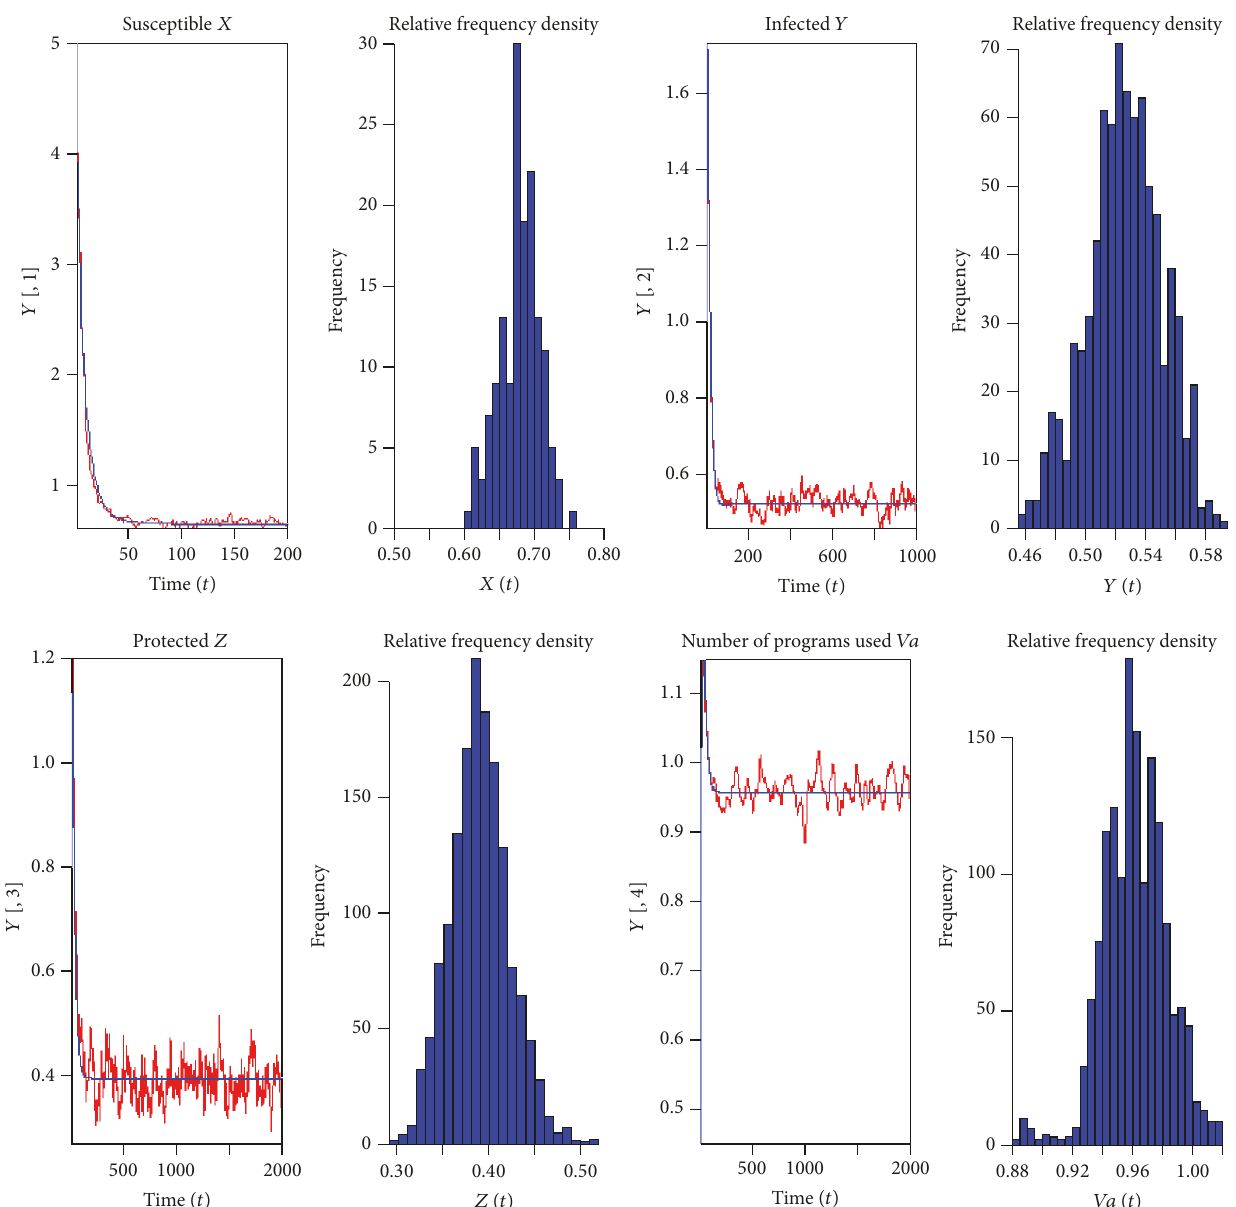
Figure 2: The solution of stochastic model (3) and its histograms with parameters in Example 15 and initial values (𝑋(0),𝑌(0),𝑍(0), 𝑉 𝑎 (0)) = (5,1,0.8, 0.45)